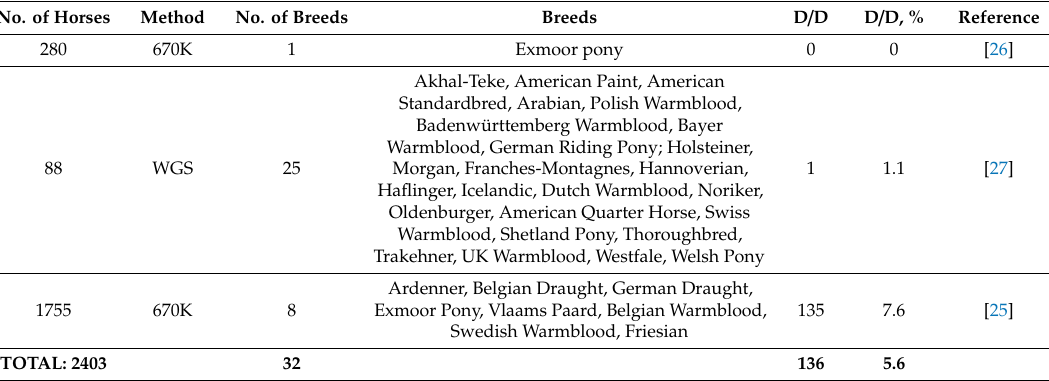
Table 4. Occurrence of ECA29 deletion in general equine